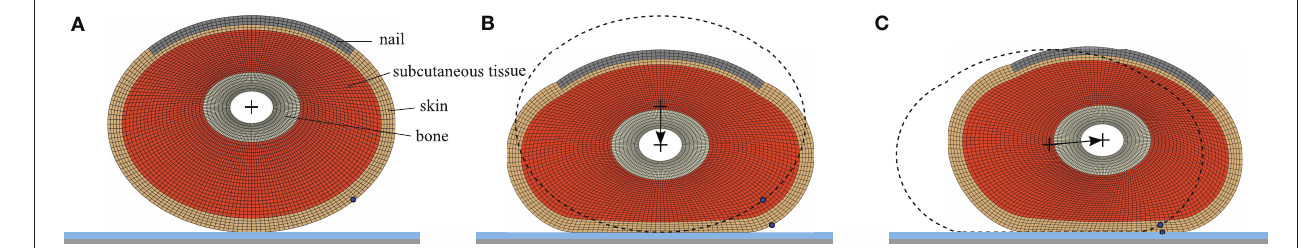
FIGURE 6 | Layered finite element model of the cross-section of the fingerpad. (A) Undeformed mesh. (B) Deformed mesh prior to tangential displacement with F N 0.8 N/mm. (C) Deformed mesh in the state of full slip with the coefficient of friction µ =